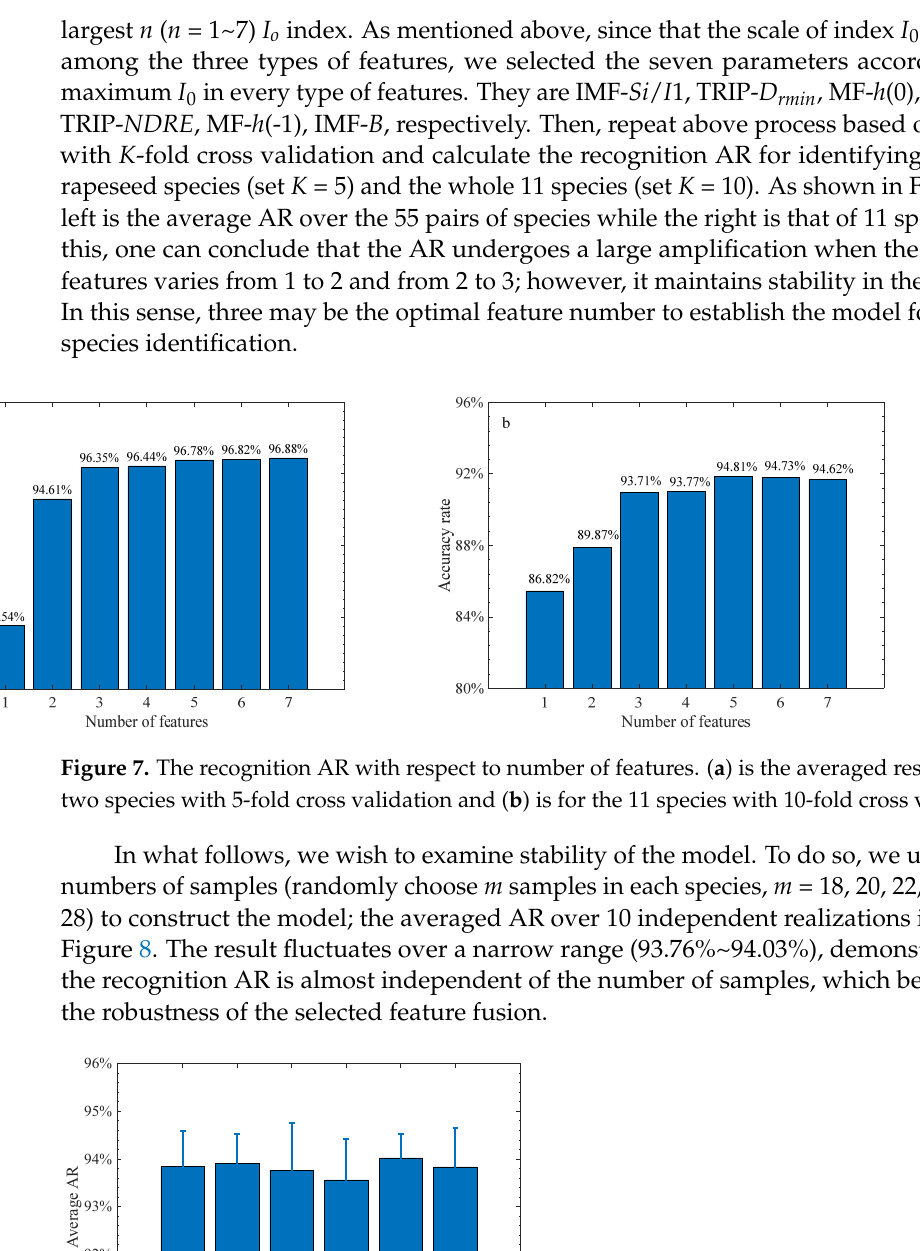
Figure 6. The average AR between two varieties under different feature combinations.